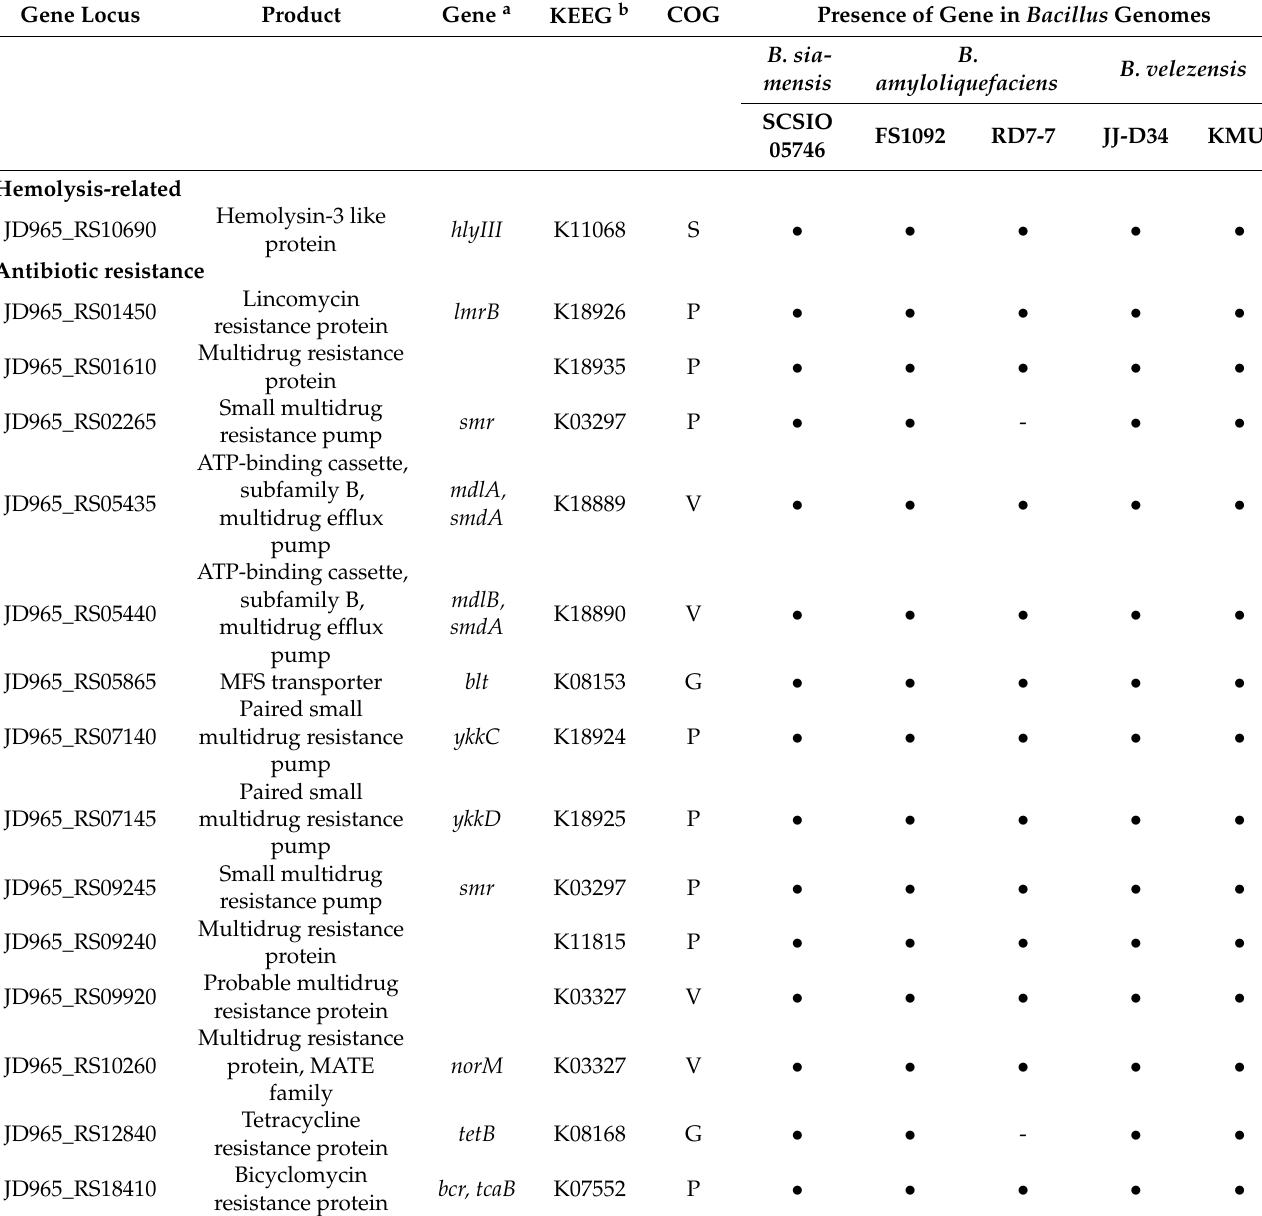
Table 2. Potential virulence determinants identified in Bacillus siamensis and genomes of related species. Gene